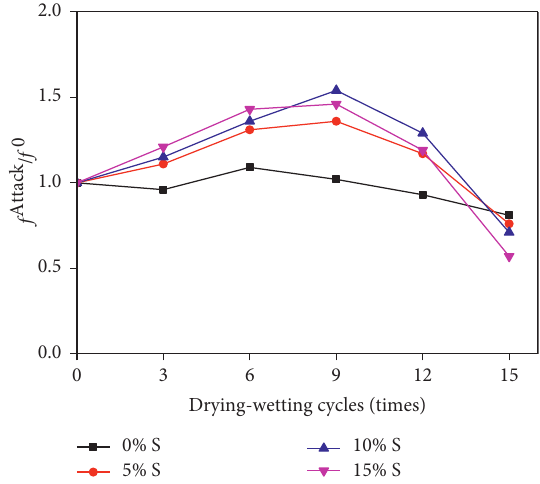
Figure 4: Mass changes of CGFB samples under sulfate attack of drying-wetting cycles.